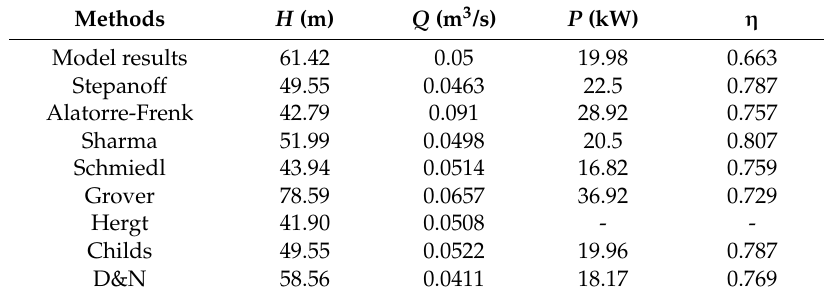
Table 4. Comparison for pump 1.